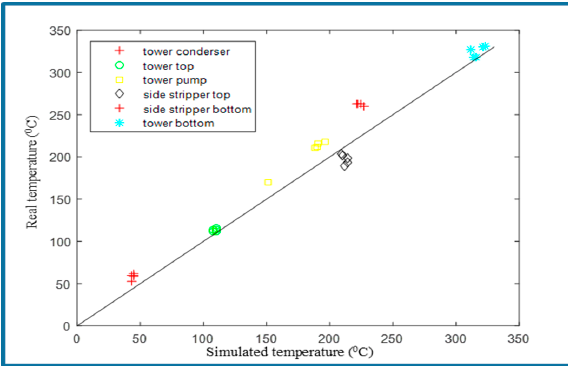
Figure 15. Prediction of the temperature profile of the fractionator. Table 6. Prediction relative deviations of the product